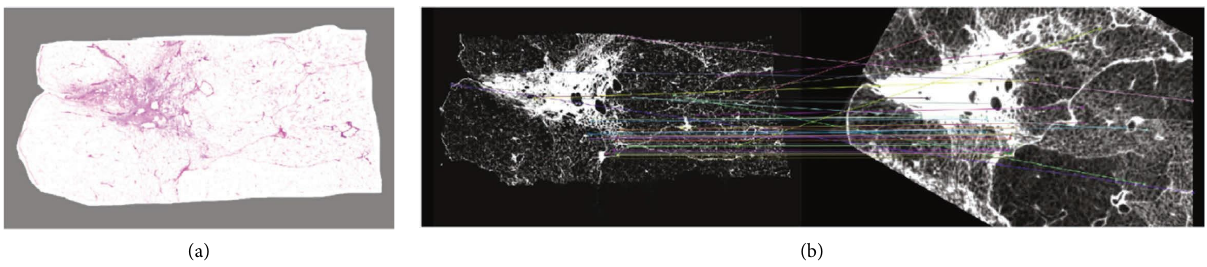
Figure 8: Matched histological slice with a CT-plane of a H and E-stained lung specimen following the method presented by Nagara et al. [49]. Te original histological image (a) was converted into a grayscale representation and subsequently matched with the corresponding CT-plane based upon AKAZE features (b). Te individual colors represent unique feature points identifed in both modalities, which are connected by lines. Reprinted by permission from Springer Nature customer service center GmbH: Springer Nature patch-based techniques in medical imaging. Patch-MI 2017. Lecture notes in computer science vol 10530. Micro-CT guided 3D reconstruction of histological images, Kai Nagara, Holger R Roth, Shota Nakamura, Hirohisa Oda, Takayasu Moriya, Masahiro Oda, and Kensaku Mori., copyright© 2017 springer international publishing AG.